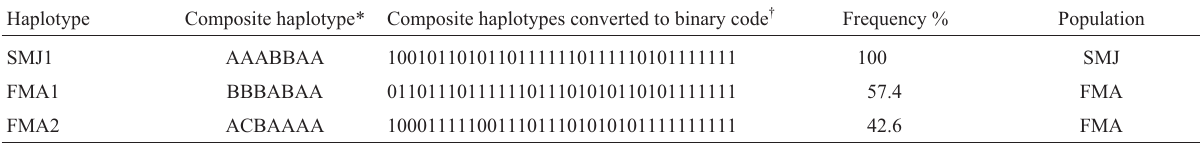
Table 2 - Composite haplotypes obtained after PCR-RFLP analysis of HVRI in 126 northern muriqui monkeys from Santa Maria de Jetibá in the Brazil- ian state of Espírito Santo (SMJ population, n = 18) and Feliciano Miguel Abdala in the Brazilian state of Minas Gerais (FMA population, n = 108). FMA1 and FMA2 represent the two haplotypes from FMA population and SMJ1 the one from SMJ population. The binary code should be read from left to right, a ‘1’ indicating the production of a restriction fragment of the specified size (in bp) and a ‘0’ indicating that the fragment was not detected (see footnote for